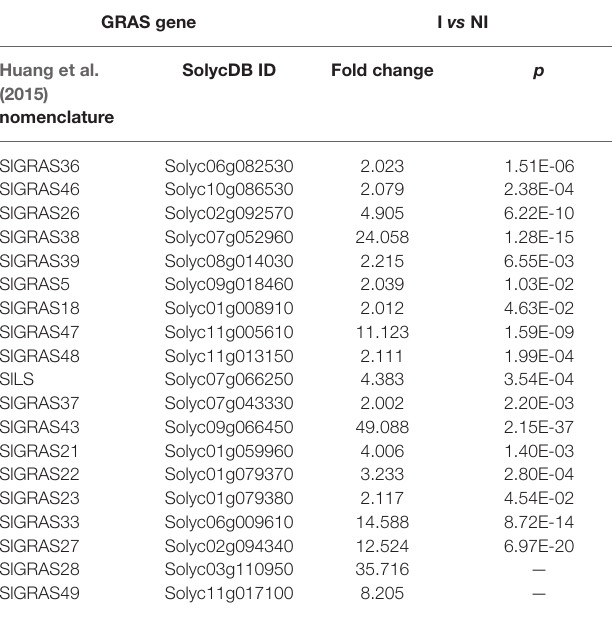
TABLE 1 | Effect of mycorrhization on the expression of GRAS family genes. GRAS